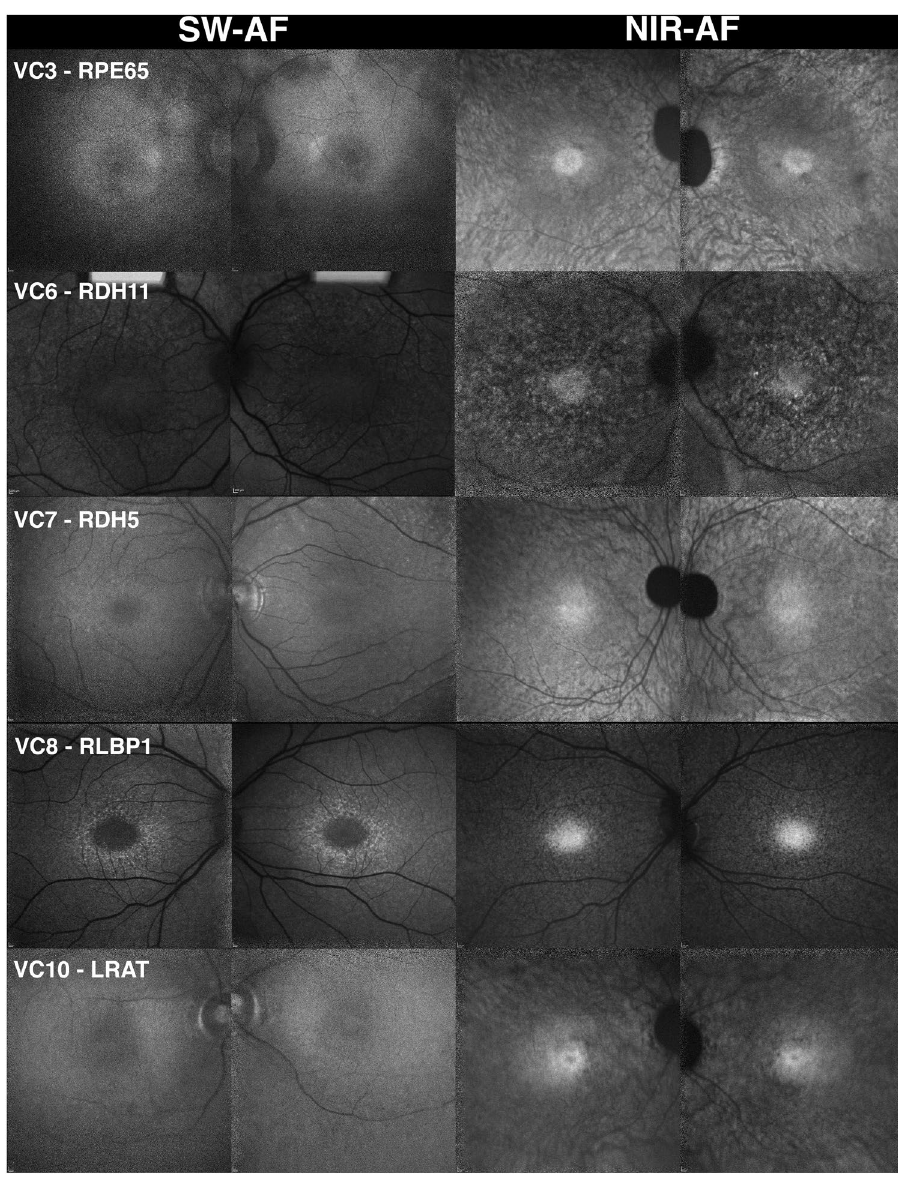
Figure 1. Fundus autofluorescence presenting in patients exhibiting mutations in visual cycle genes (VC). The short-wavelength autofluorescence (SW-AF) images of five patients carrying mutations in visual cycle genes, including RPE65 , LRAT , RLBP1 , RDH5 , and RDH11 , indicate that the feature common to this cohort is dark or absent autofluorescence illustrated by fluorescence intensity in the vasculature and optic nerve that is similar to the rest of the macula. Choroidal vessels are visible in the near-infrared autofluorescence (NIR-AF) images in the patients with mutations in RPE65, LRAT , and RDH5 . This suggests a reduction in NIR-AF from RPE melanin. A hyperautofluorescent ring can be seen in the patient with mutations in RLBP1 by short-wavelength autofluorescence. All other patients do not demonstrate hyperautofluorescent rings in either short-wavelength or near-infrared autofluorescence